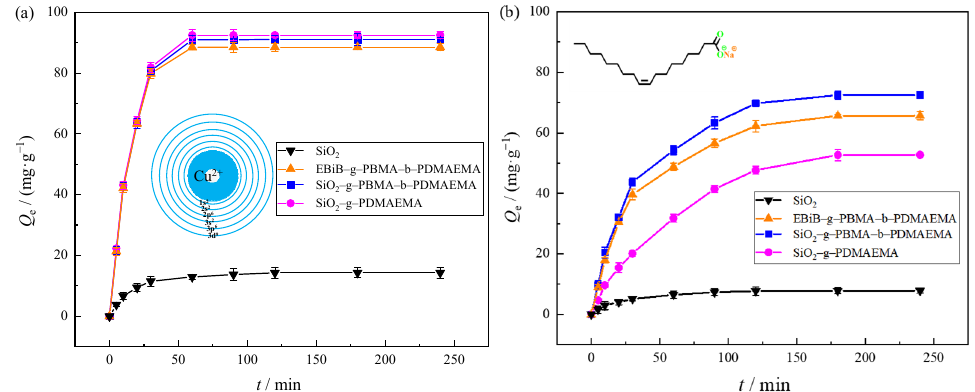
Figure 2. Adsorption kinetics of ( a ) Cu(II) or ( b ) NaOL on SiO 2 , EBiB–g–PBMA–b–PDMAEMA, SiO 2 –g–PBMA–b–PDMAEMA and SiO 2 –g–PDMAEMA ( C 0 = 100 mg·L − 1 , pH = 5, T = 25 °C, adsor- bent concentration = 1 g·L − 1 ).